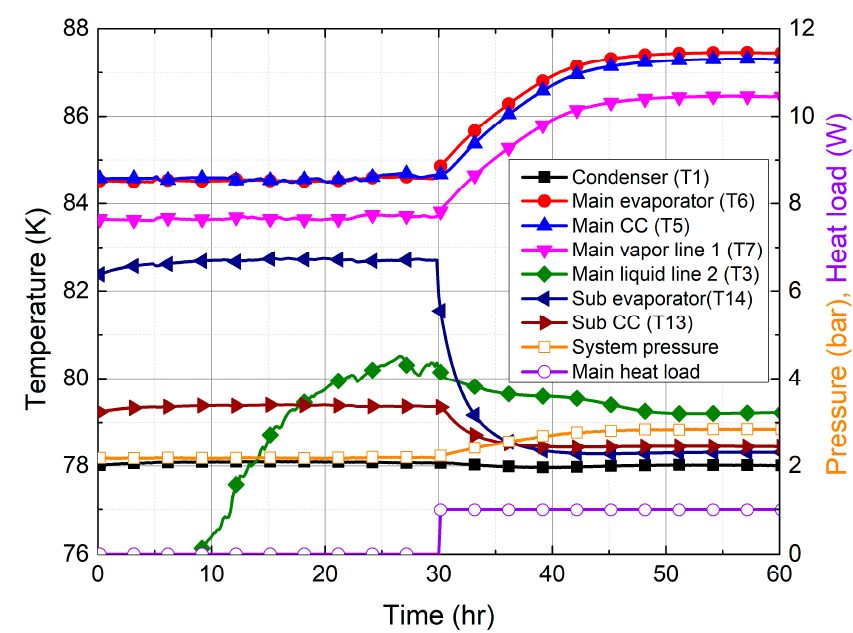
Figure 9. Temperature and pressure changes when a 1 W heat load was applied to the main evaporator after CLHP temperature convergence.